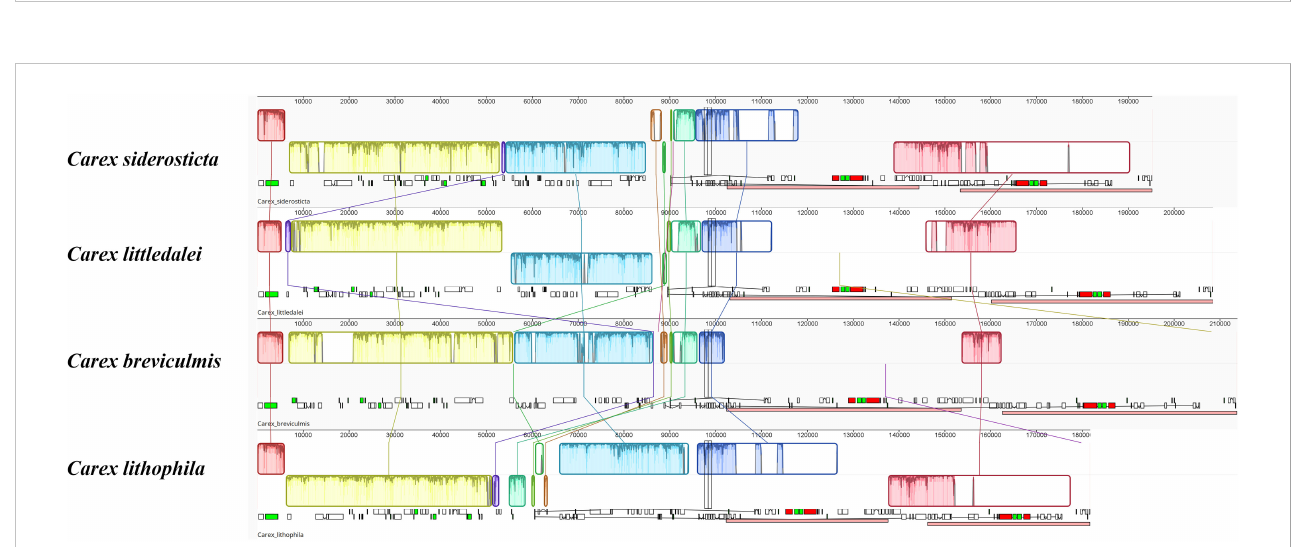
FIGURE 5 Mauve alignment offour Carex chloroplast genomes. Complete chloroplast genome sequences were aligned in Geneious using the Mauve algorithm for linear comparison of rearrangements across the Carex . Locally collinear blocks (LCBs) are coloured to indicate syntenic regions. Histograms within each block represent the degree of sequence similarity. Inversions resulting in strand change are represented as offset LCBs (below). The small boxes below each chloroplast genome indicate genes; upper and lower boxes are transcribed counterclockwise and clockwise, respectively. Red boxes indicate ribosomal RNA